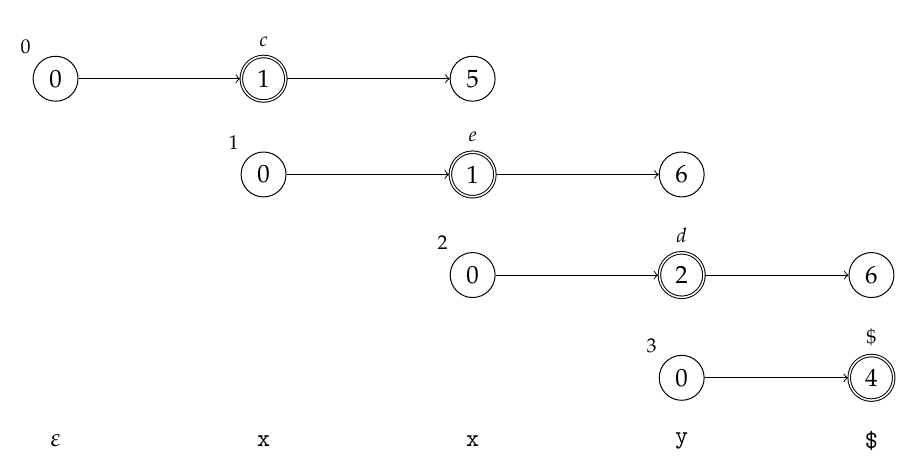
Figure 7. The GSS constructed by the context-aware scanning architecture using the specification Ξ in (2).